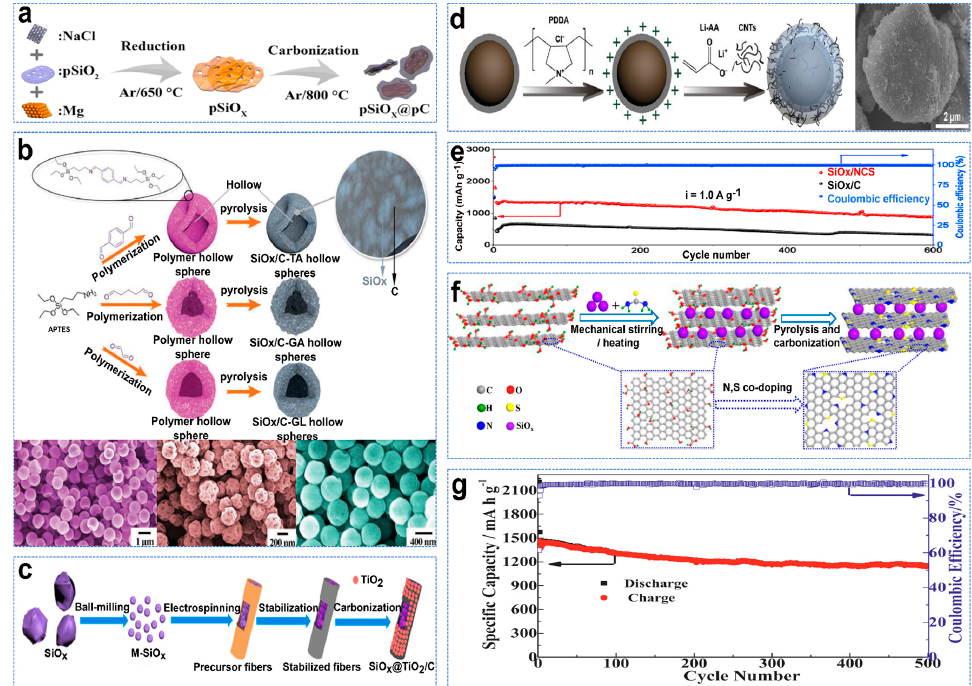
Figure 6. ( a ) Schematic illustration of the synthesis of pSiO x @pC [59]. ( b ) Schematic illustration of the synthetic procedure for SiO x /C HS − TA, SiO x /C HS − GA, SiO x /C HS − GL and SEM images [60]. ( c ) Schematic of preparation of the SiO x @TiO 2 /C fibers [62]. ( d ) Schematic illustration of the preparation of C − SiO x /C and SEM images [63]. ( e ) Long − term cycling performances of SiO x /NCS and SiO x /C at 1 A g − 1 [66]. ( f ) Schematic illustration of the fabrication process of the SiO x /N/S − rGO composite. ( g ) Cycling performance at 0.5 A g − 1 [68].